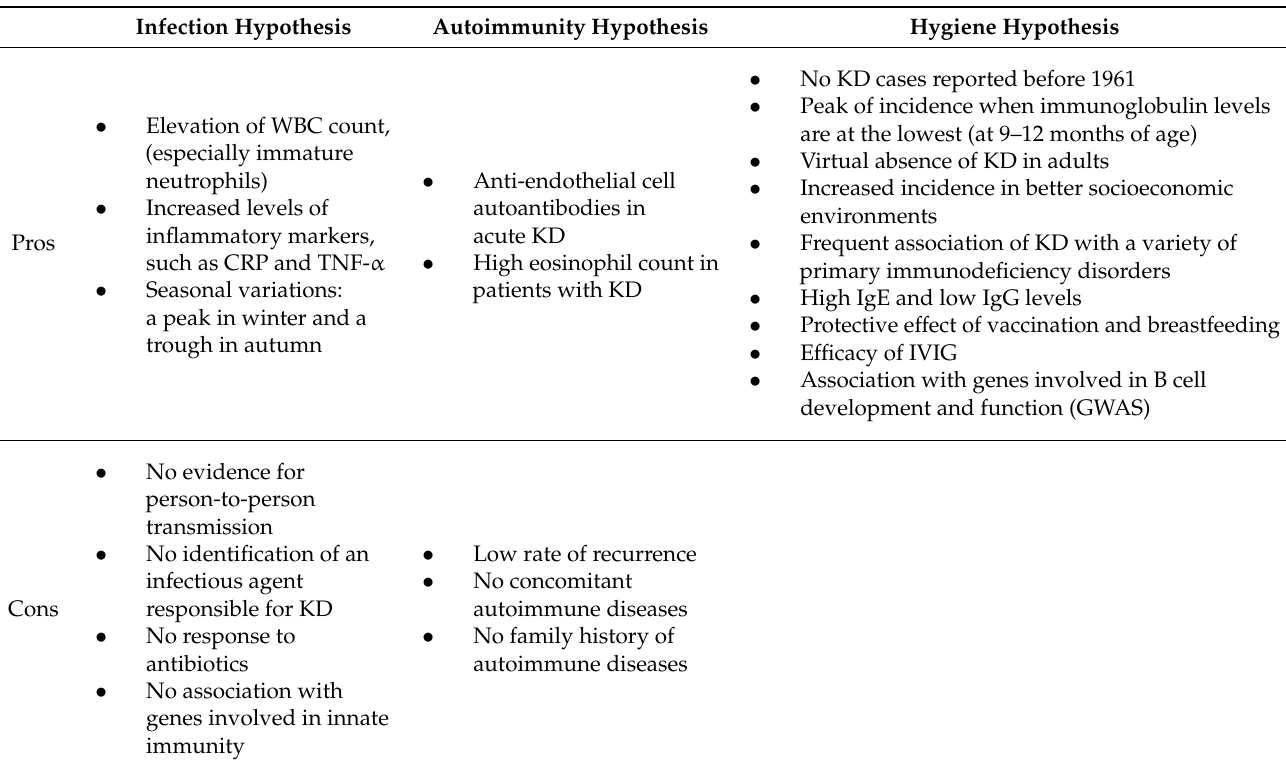
Table 1. Three hypotheses that explain the etiology of